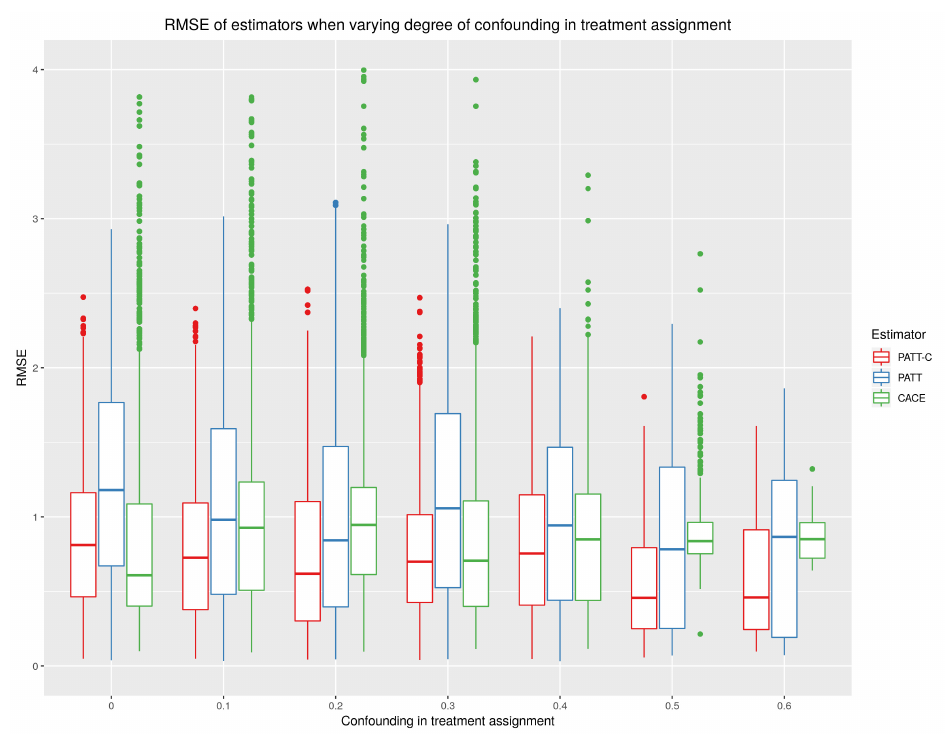
Figure B2: Average RMSE according to degree of confounding in treatment assignment.